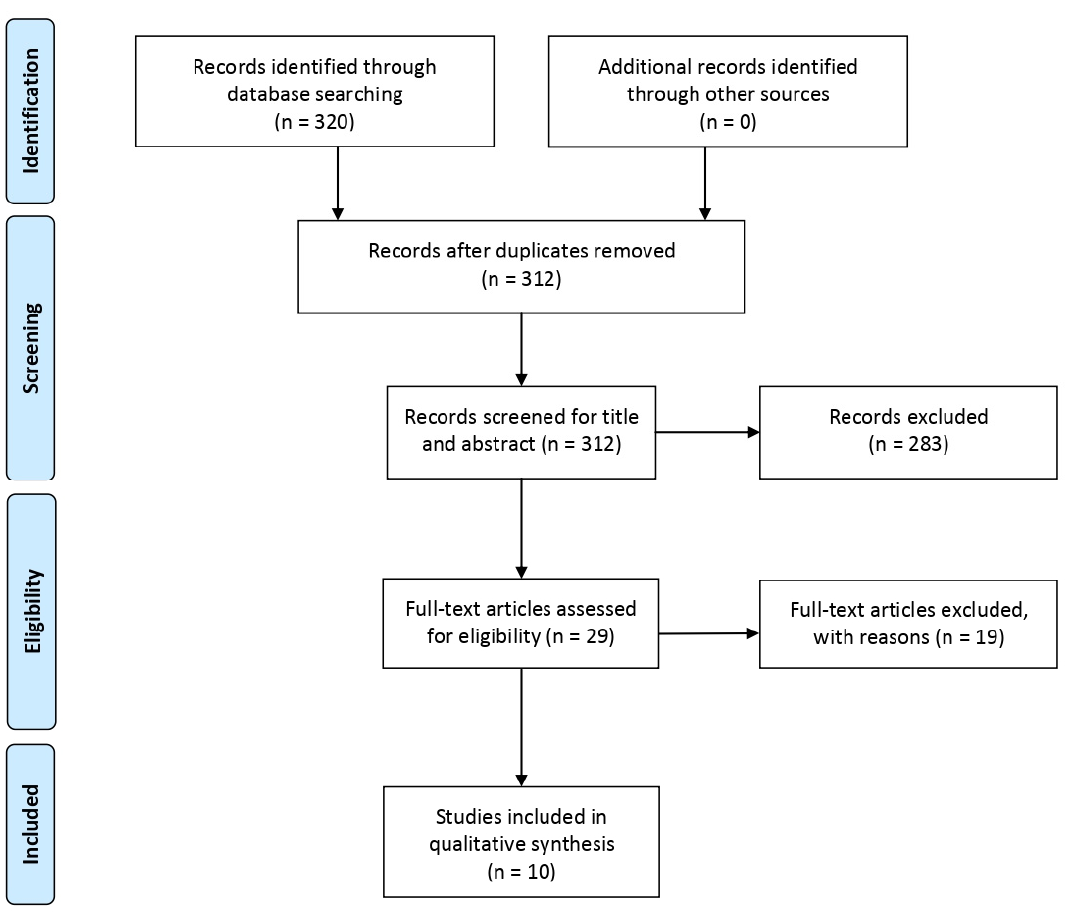
Figure 1. Flowchart of number of articles retrieved during the literature search and study selection. Table 1. Main characteristics of the studies included in this review and related CEBM levels of